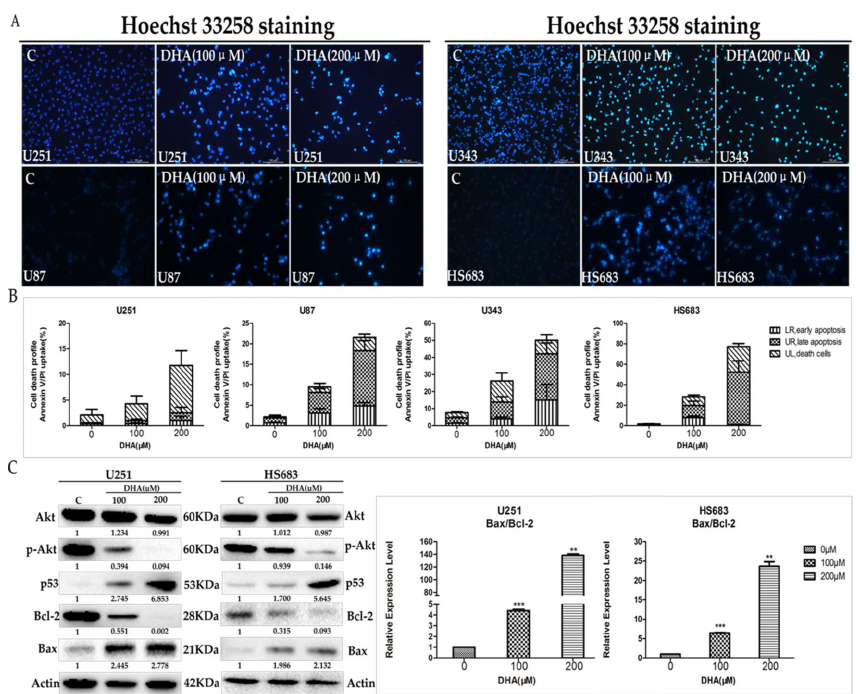
Figure 1. Effect of DHA on malignant glioma cells’ apoptosis by regulating AKT axis. The indicated Figure 2. Effect of DHA on malignant glioma cells apoptosis by regulating AKT axis. The indicated cells were treated with 100 and 200 μM DHA for 48 h. ( A ) Cells stained with Hoechst 33,258 were cells were treated with 100 and 200 µ M DHA for 48 h. ( A ) Cells stained with Hoechst 33258 were detected and calculated by fluorescent photomicrographs at 10×. Scale bar = representative results detected and calculated by fluorescent photomicrographs at 10 × ; ( B ) cells were labeled with Annexin V/Propidium Iodide (AnnexinV/PI) and detected by flow cytometry. Values were mean ± SD ( n = 3); ( C ) the proteins associated with AKT/p53/Bcl-2/Bax axis in malignant glioma cells were determined by western blot analysis. The changes of Bax/Bcl-2 ratio were evaluated by western blot analysis. Values were mean ± SD ( n = 3). ** p < 0.001, *** p < 0.0001 as compared with negative control